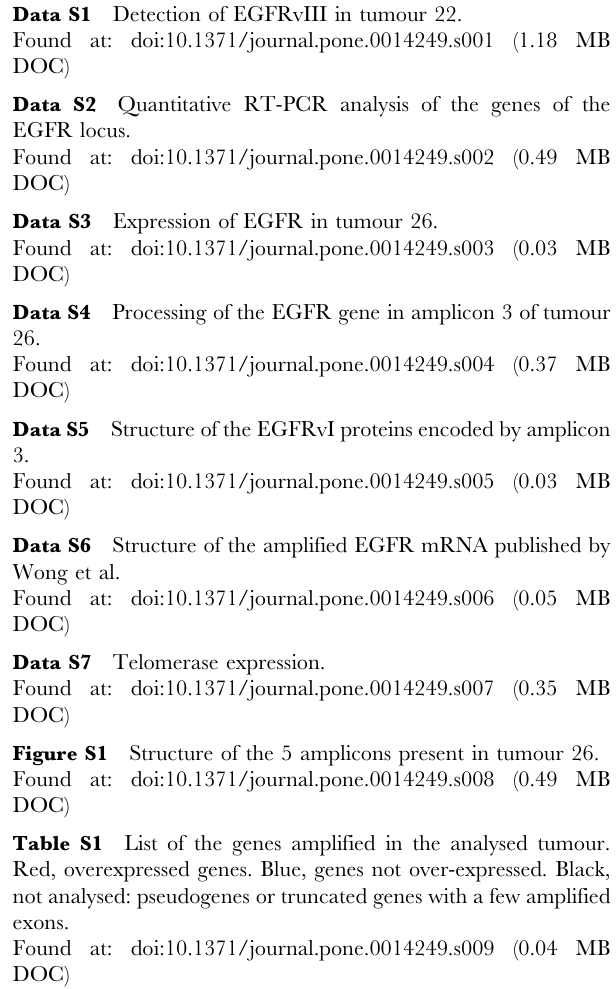
Table S1 List of the genes amplified in the analysed tumour. Red, overexpressed genes. Blue, genes not over-expressed. Black, not analysed: pseudogenes or truncated genes with a few amplified